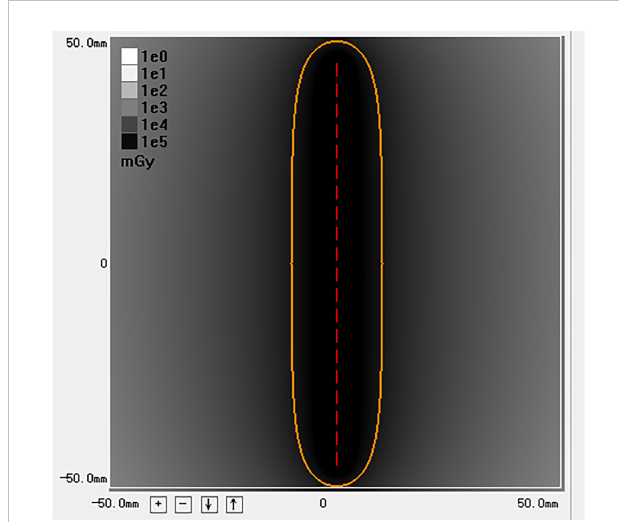
FIGURE 2 This image is the radiation distribution of a strand loaded with 20 125 I seeds simulated by the calculation software. The yellow circle represents a 100% isodose contour (r = 10mm). The 240 days ’ intended dose of this 125 I seed strand is 63.5